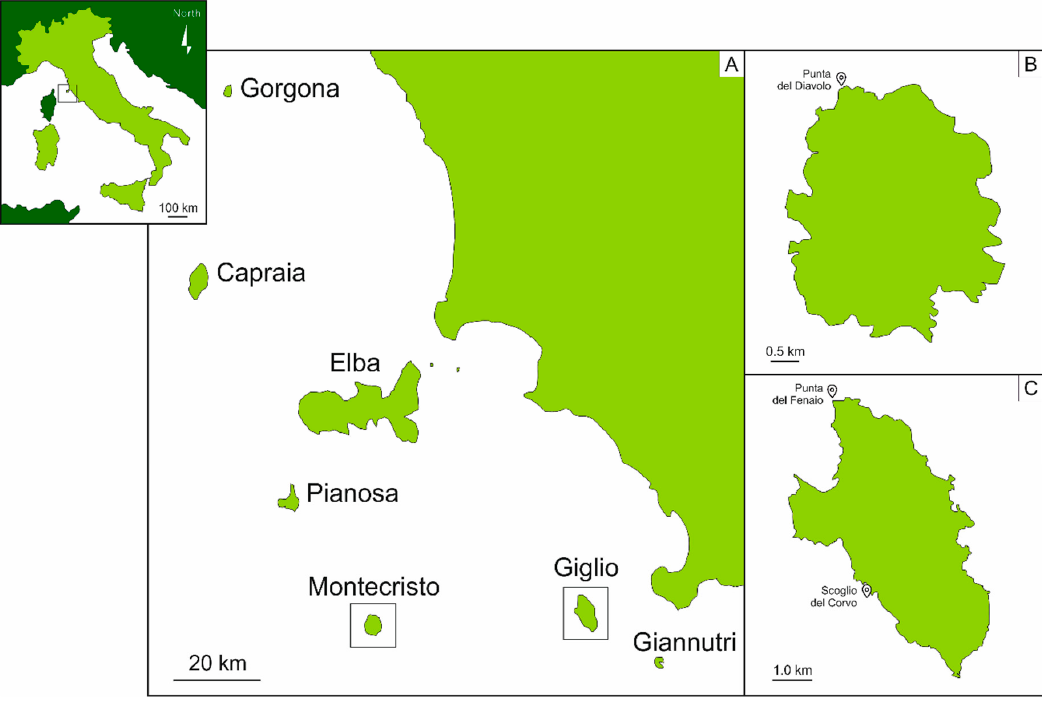
Figure 1. Map of the Tuscan Archipelago National Park (TANP) ( A ), Montecristo Island ( B ) and Giglio Island ( C ). The sampling sites are indicated in the islands’ maps.